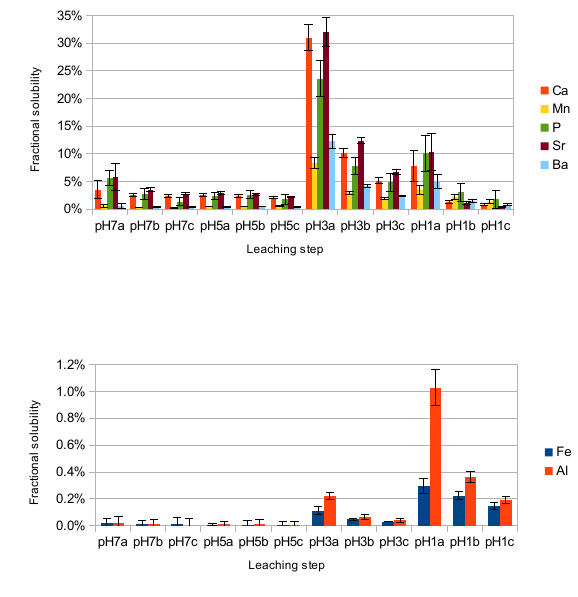
Figure 1. Average fractional solubility relative to the initial quantity of the element measured for each leaching step from pH7a to pH1c for each group. A) Ca, Mn, P, Sr, Ba (group 1), B) Al and Fe (group 2). The segments are the standard deviation of the four replicated experiments. The corresponding measured pHs for batches "pH7", "pH5", "pH3" and "pH1" are 8, 6.7, 3 and 1.1, respectively.